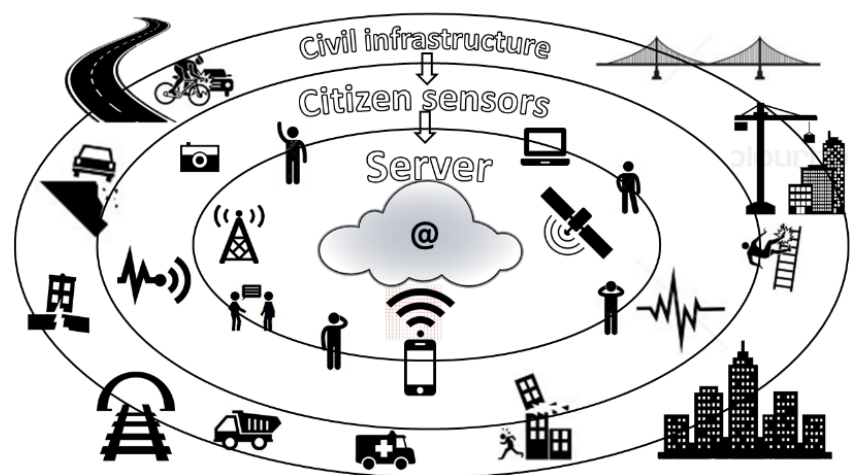
Figure 3. Conceptual CPS scheme for smartphone-based SHM.